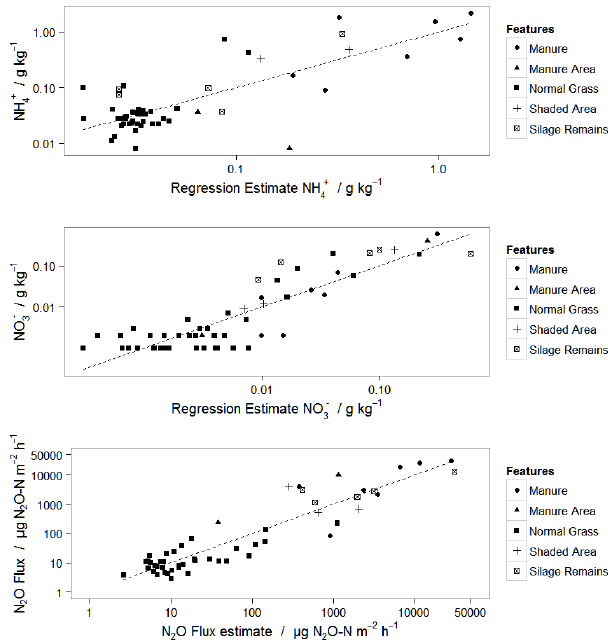
Figure 6. Multiple linear regression used to identify relationships between NH + (a) , NO − (b) and N 2 O flux (c) with soil proper- 4 3 ties measured during flux measurements from grazed grassland (See Table 2 for fitting parameters). All 55 soil samples collected from multiple features present in the field were included in the regression